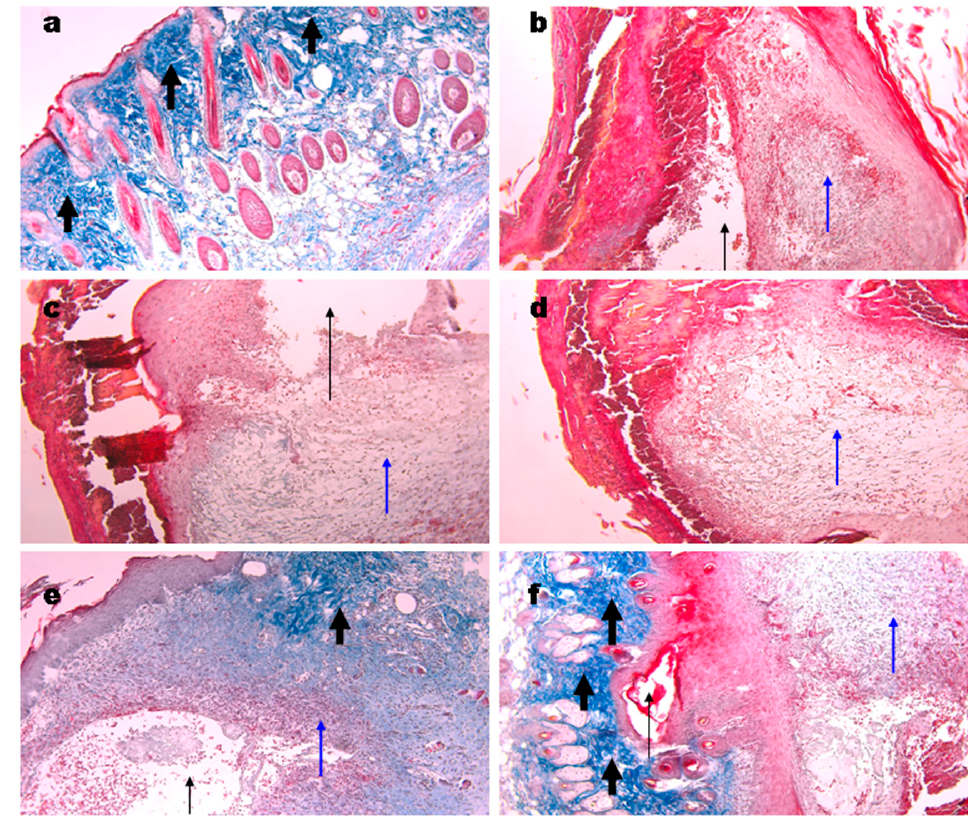
Figure 8. Representative images of the Masson’s trichrome staining of the wound biopsies. Histology of normal skin ( a ), at days 4 ( b ), 5 ( c ), 6 ( d ), 7 ( e ), and 10 ( f ) of wound controls. Thin black arrows show open cavities; thin blue arrows show granulomatous tissue; thick black arrows show collagen deposition. Magnification 100×.